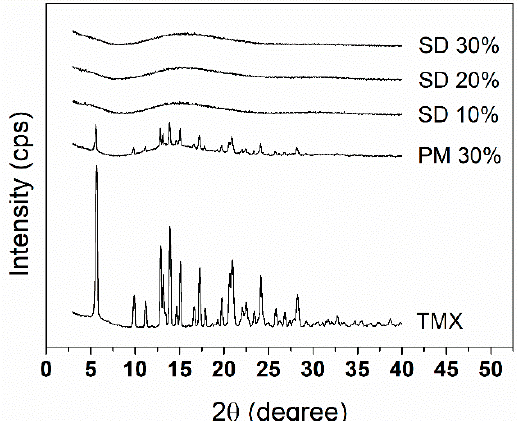
Figure 1. X-ray di ff raction (XRD) di ff ractogram patterns of solid dispersions (SDs) 10%, 20%, and 30%; Figure 1. X-ray diffraction (XRD) diffractogram patterns of solid dispersions (SDs) 10%, 20%, and physical mixture (PM) 30%; and crystalline tamoxifen (TMX). 30%; physical mixture (PM) 30%; and crystalline tamoxifen (TMX).